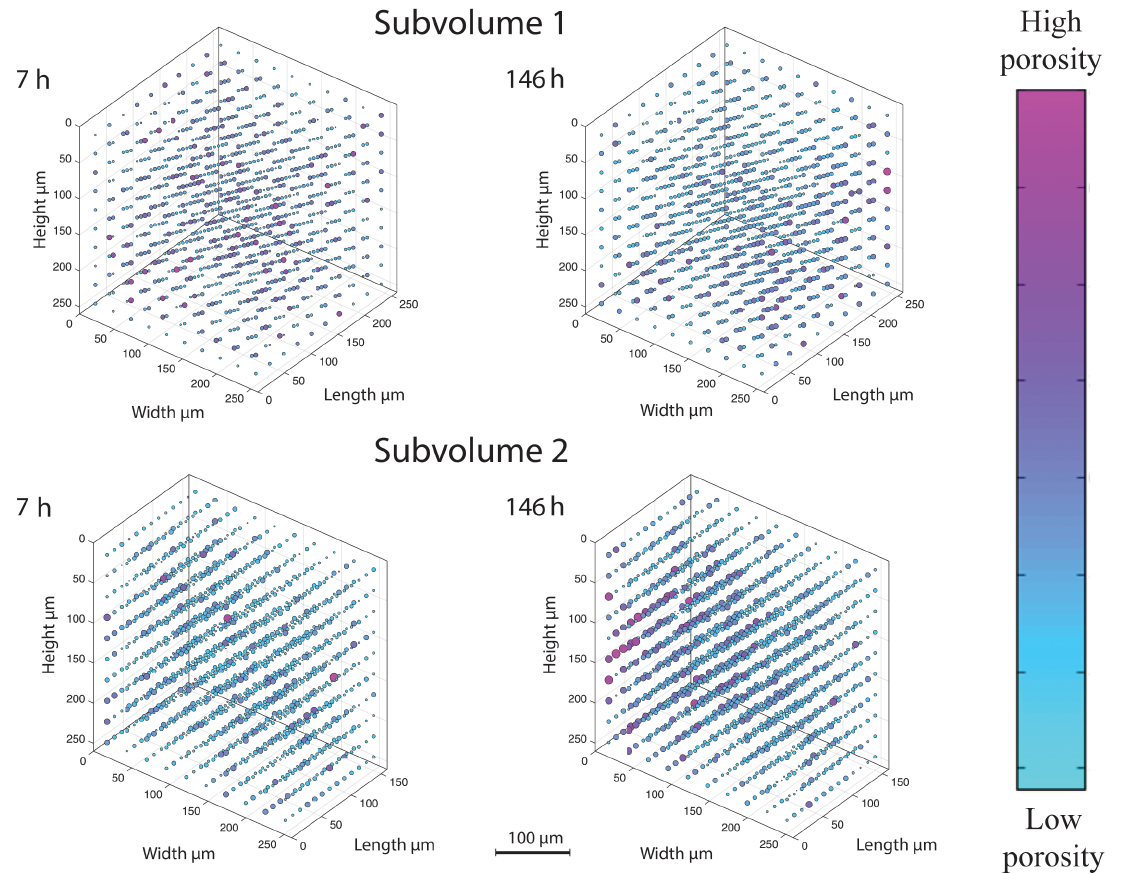
Figure 14. Pore distribution within the subvolumes from SGC sample. For subvolume 1, which contains a more inner part of the sample, porosity is relatively homogenous among the volume. For subvolume 2, as it contains a more outer part of the sample, a concentration of high porosity can be found in the outer edge compared to the inner edge of the subvolume. This contrast in porosity also reflects a non-uniform precipitation which generates stress that fractures the